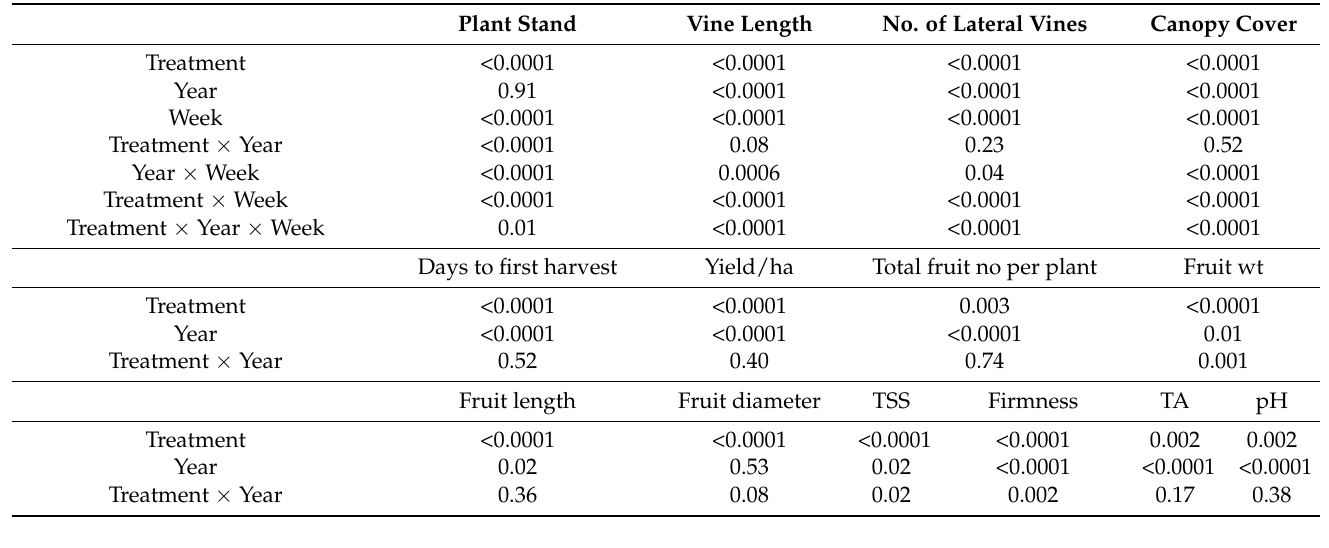
Table 3 . Results ( p -values) from analysis of variance of the main factors “treatment”, “year”, and “weeks after transplanting” (week), and their interactions, for the parameters measured for grafted and nongrafted cantaloupe treatments in 2020 and 2021.